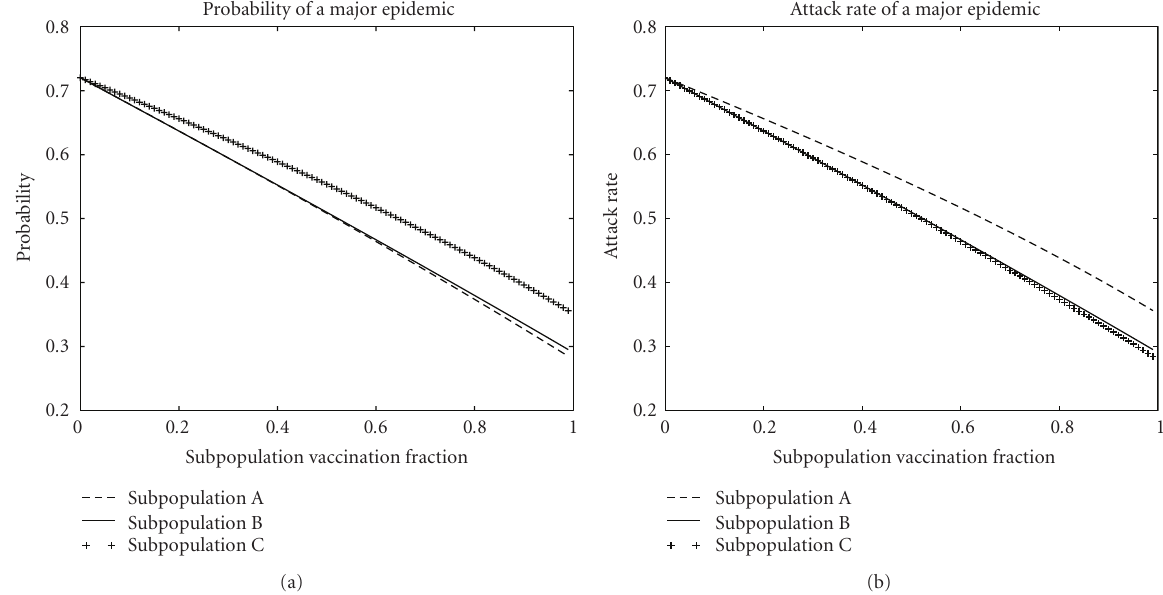
Figure 5: E ff ects of vaccination on the probability and attack rate of a major epidemic in the mass-action model from Section 4.1. Vaccinating subpopulation A, the most infectious and least susceptible, is optimal for reducing the probability. Vaccinating subpopulation C, the most susceptible and least infectious, is optimal for reducing the attack rate. Vaccinating subpopulation B, of average infectiousness and susceptibility, is nearly optimal for both.